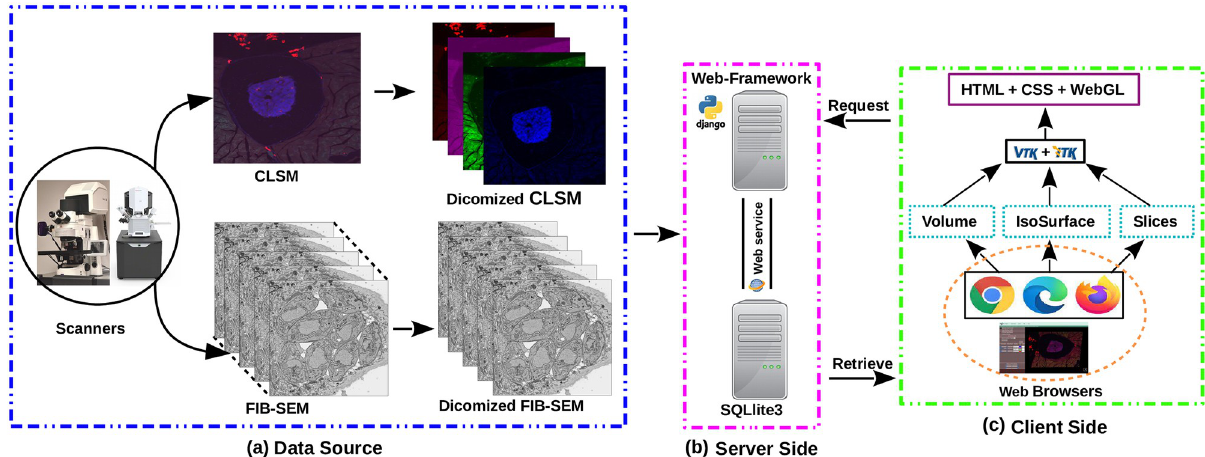
Fig 3. Framework for an interactive 3D viewer. (a) Acquisition of multidimensional images and conversion to the DICOM standard; (b) Development of a web server using the Django web-framework; and (c) Implementation of visualization techniques in the client-side framework.